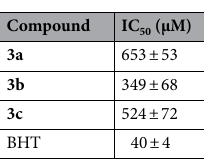
Table 1. In vitro antioxidant activity of hydroxyxanthone derivatives.